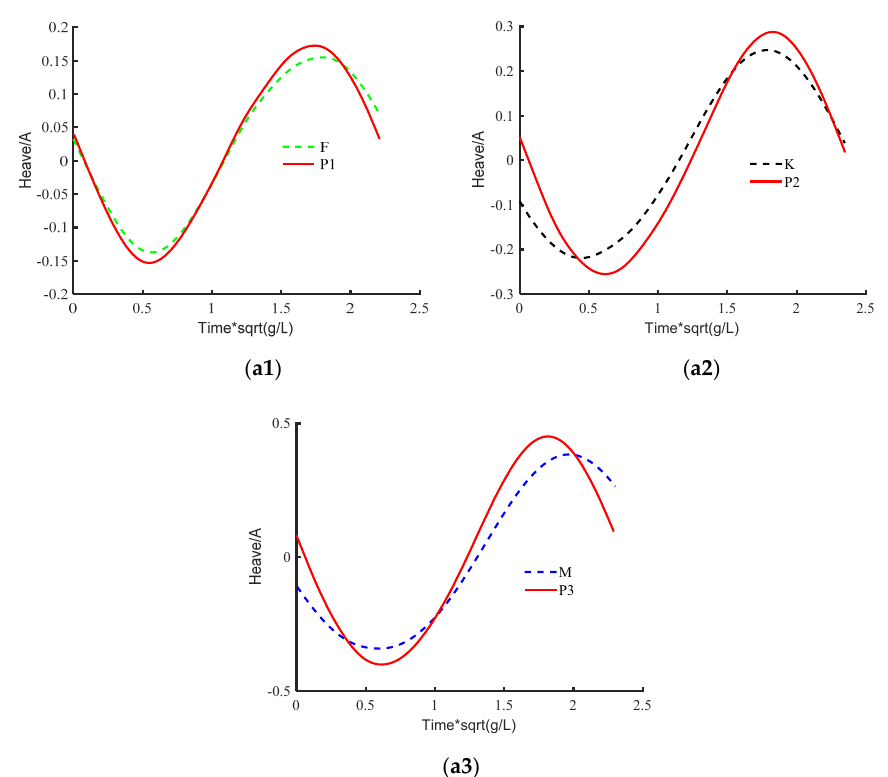
Figure 11. Effects of ship’s speed on rigid body motion response with different λ /L. ( a1 ) time series of heave with λ /L = 0.857; ( a2 ) time series of heave with λ /L = 1.07; ( a3 ) time series of heave with λ /L = 1.228.